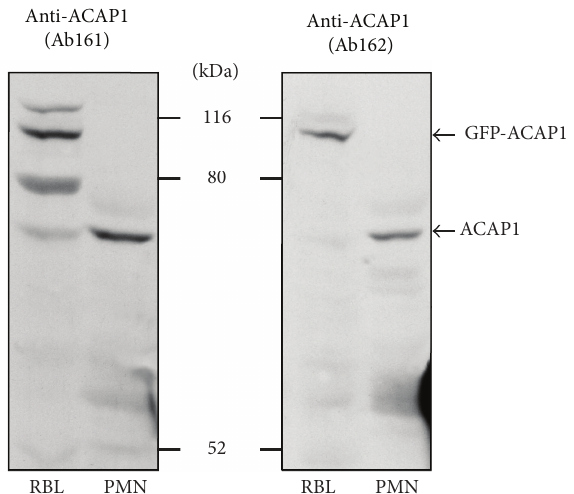
Figure 3: Expression of ACAP1 by human PMNs. Lysates from RBL-2H3 cells (0.5 × 10 6 ) overexpressing ACAP1-GFP and human PMNs (2 × 10 6 ) were subjected to 8% SDS-PAGE and proteins were transferred to Immobilon PVDF membrane. Membranes were incubated with our homemade polyclonal antibodies (serums 161 and 162) against ACAP1 (1:1000) and exposed to peroxidase-conjugated anti-rabbit IgG (1:20,000) for 1h at 37 ∘ C. The membranes were covered with ECL+ detection reagents. Images were obtained by exposing Kodak X-Omat film to